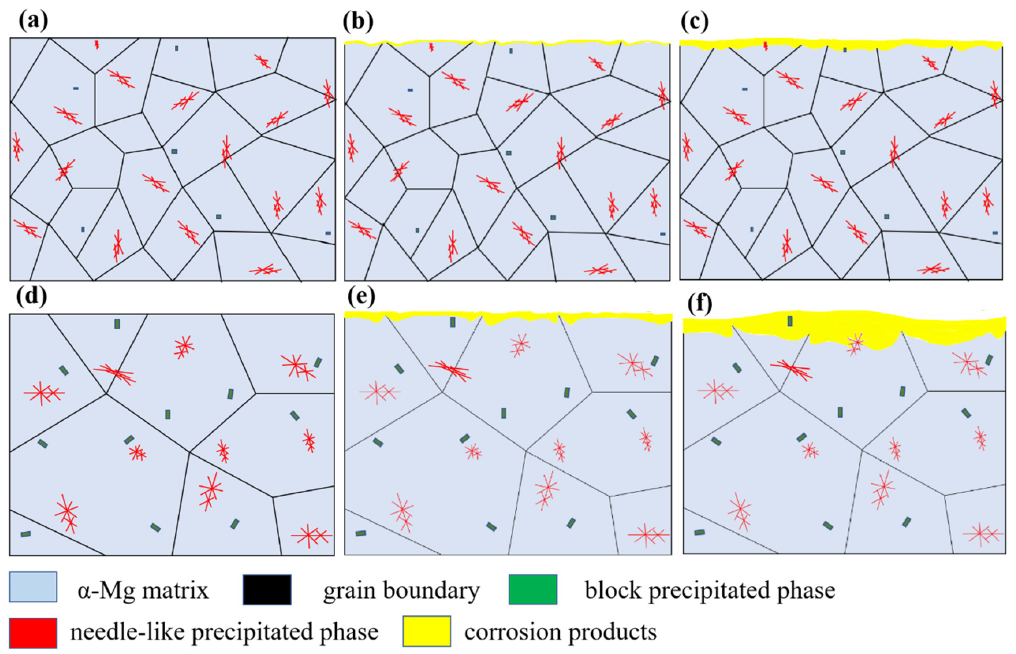
Figure 10. Schematic diagrams showing corrosion processes of T6-treated GZ61K ( a – c ) and GZ91K ( d – f ) ( d – f ) alloys.